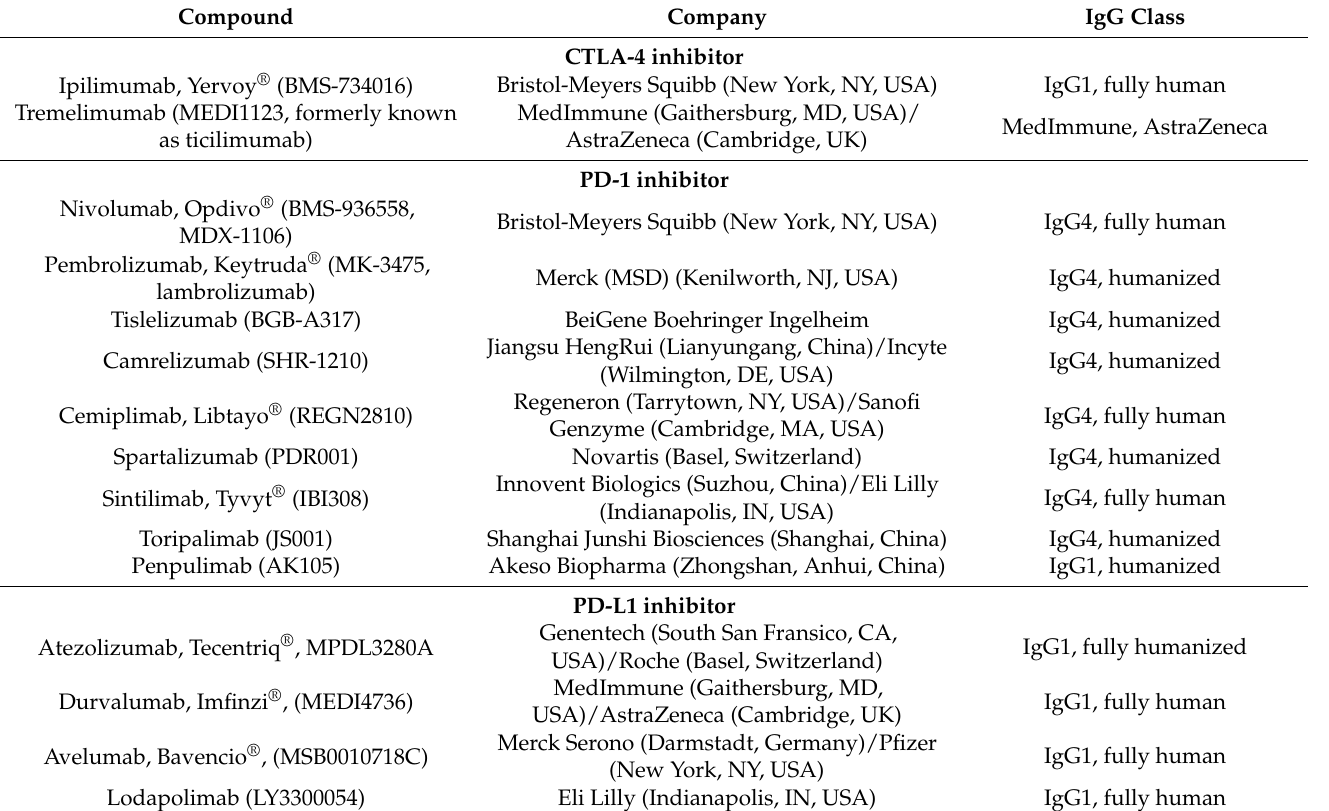
Table 1. Immune checkpoint inhibitors under evaluation in clinical trials in hepatocellular